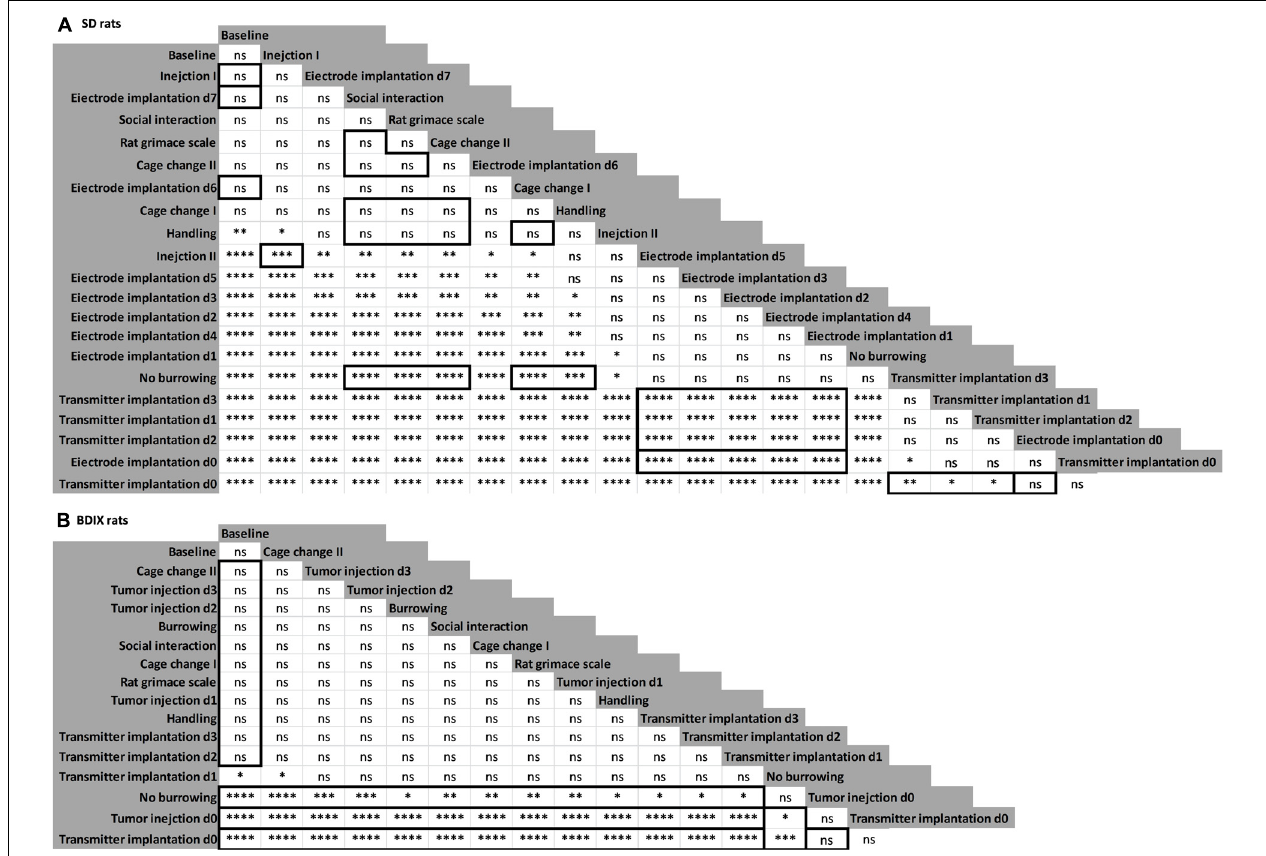
FIGURE 4 | Statistical comparison of severity fractions of procedures. The fractions of data allocated to class high HR/low Act were statistically compared using a Fisher’s exact test; for SD rats (A) and BDIX rats (B) ; framed fields that are described in the section “Results”; * P < 0.05, ** P < 0.01, and *** P <